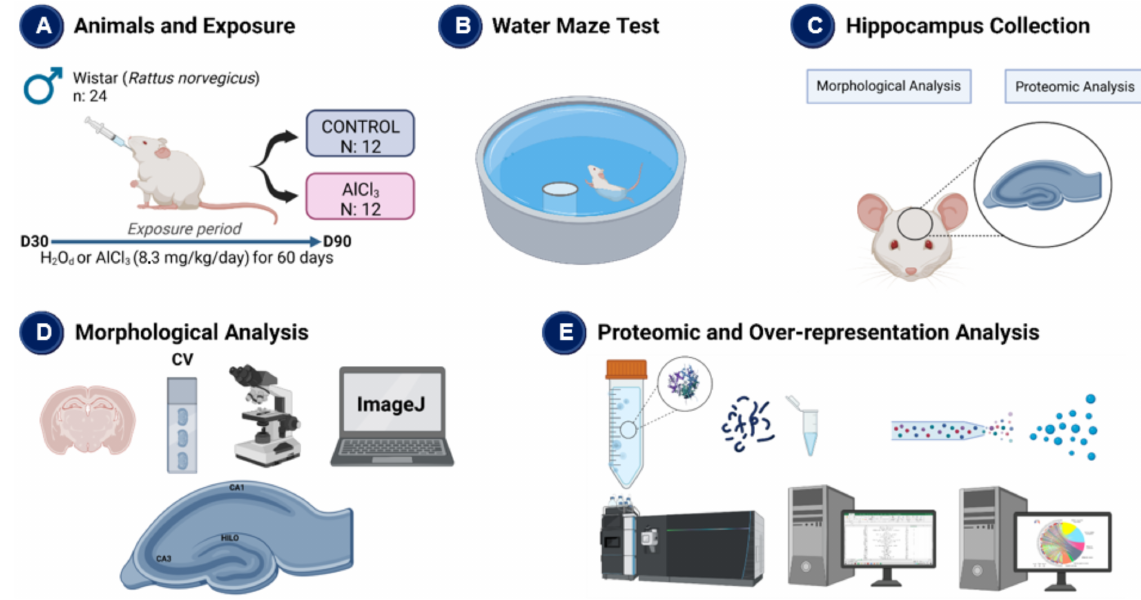
Figure 5. Methodological steps of the study. ( A ) Description of experimental groups and exposure to aluminum chloride (AlCl 3 ) or distilled water (H 2 O d ); ( B ) After the Al exposure protocol, the animals were submitted to the Water Maze Test; ( C ) After the Water maze test, the animals were euthanized, and the hippocampus was collected ( D ) Histological analysis with cresyl violet (CV) staining in the hippocampus, along the regions CA1, CA3 and hilus; ( E ) Proteomic analysis by mass spectrometry and